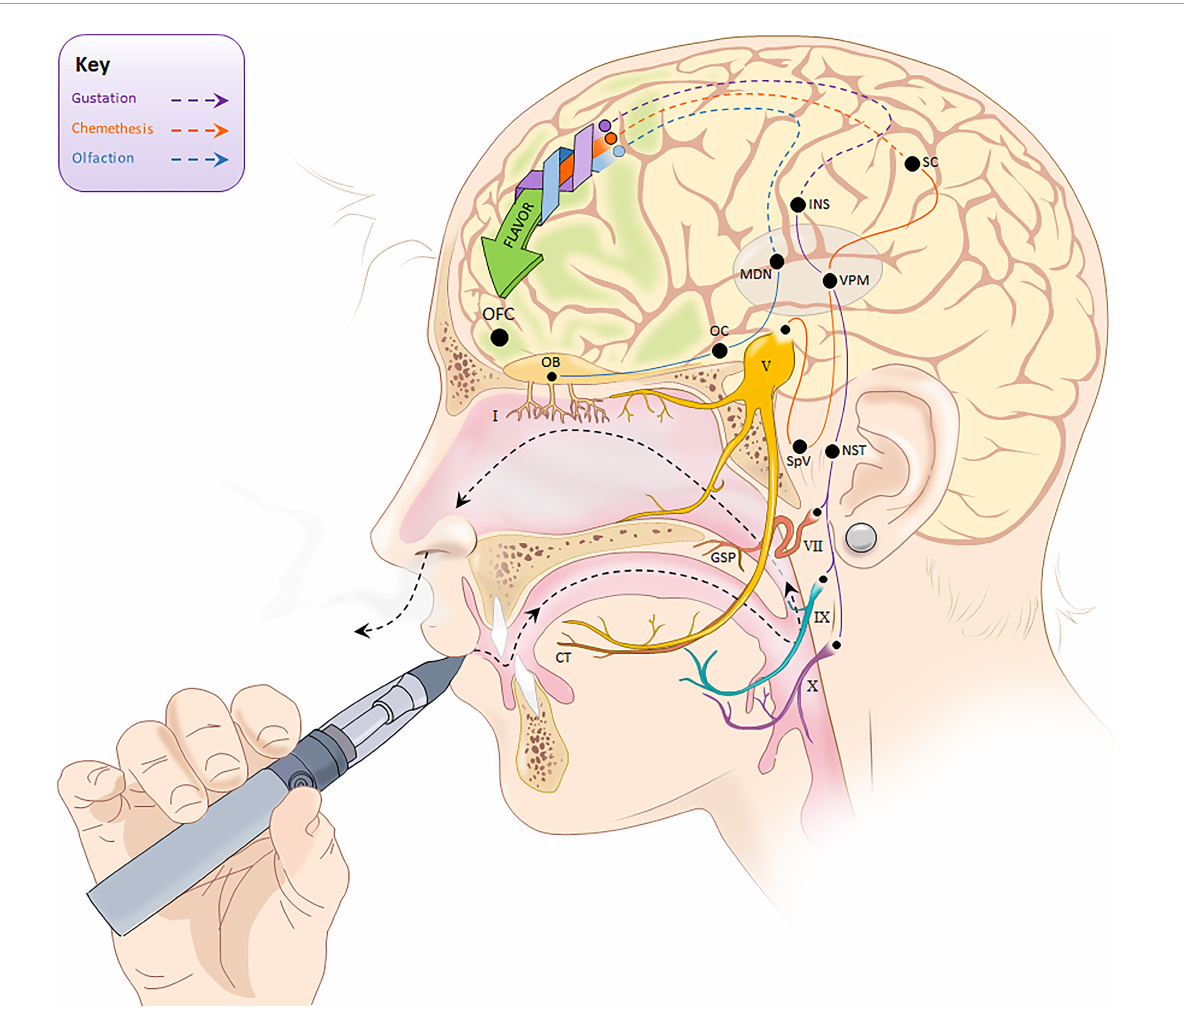
FIGURE1 Summary of three distinct sensory pathways involved in flavor perception. Taste, smell, and chemesthesis are integrated in the orbitofrontal cortex (OFC) to generate the unitary percept that we call flavor. Taste signals are carried by Cranial Nerves VII, IX, and X to the nucleus of the solitary tract (NST), which connects to the Ventral Posteromedial Nucleus (VPM) within the Thalamus. The VPM projects to the taste cortex located in the Insula. CN VII (the facial nerve) has two branches involved in taste: the chorda tympani (CT) innervates the anterior tongue while the greater superficial petrosal nerve (GSP) innervates the palate. Smell signals are carried by Cranial Nerve I through the cribriform plate to the olfactory bulb (OB), the Olfactory Cortex (OC), and then the Medial Dorsal Nucleus (MDN) within the Thalamus. Chemesthetic signals are carried by multiple cranial nerves (see Green, 2016), but for simplicity, only the trigeminal nerve (CN V) is shown here. Separate branches of the trigeminal nerve come together in the trigeminal ganglion (not shown), before descending to the spinal trigeminal nucleus (SpV) in the brain stem. From the SpV, signals ascend contralaterally to the VPM in the Thalamus, and then to the Somatosensory Cortex (SC). (Some anatomical landmarks in the brain have been omitted, and positions shown here may not be